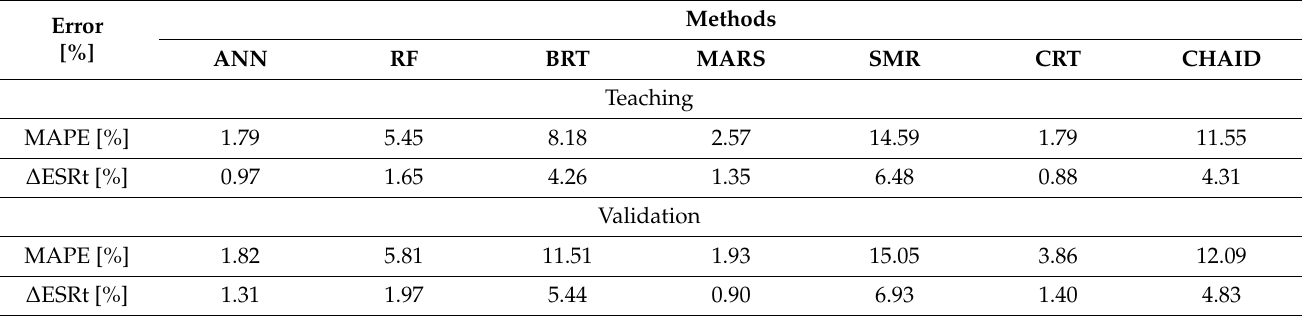
Table 6. List of errors for the used methods of modeling the energy stored in the PCM battery, determined on the basis of the energy supplied to the fan, paraffin